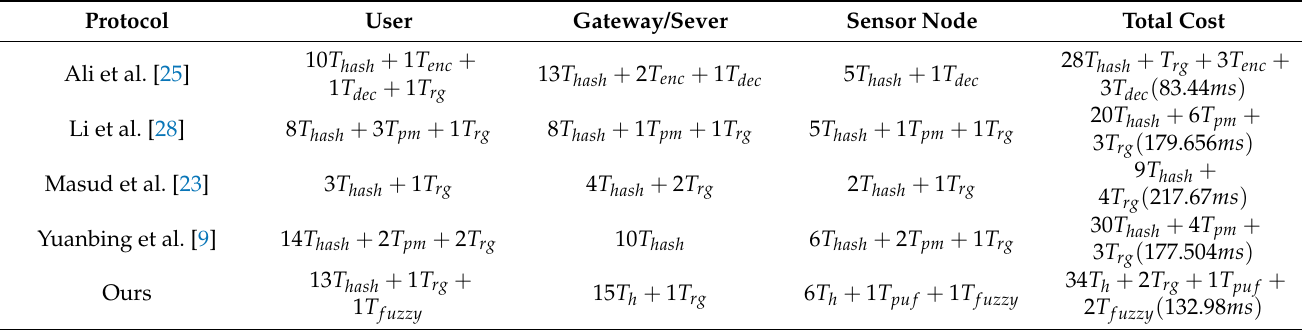
Table 3. Computation costs at login and authentication phase.